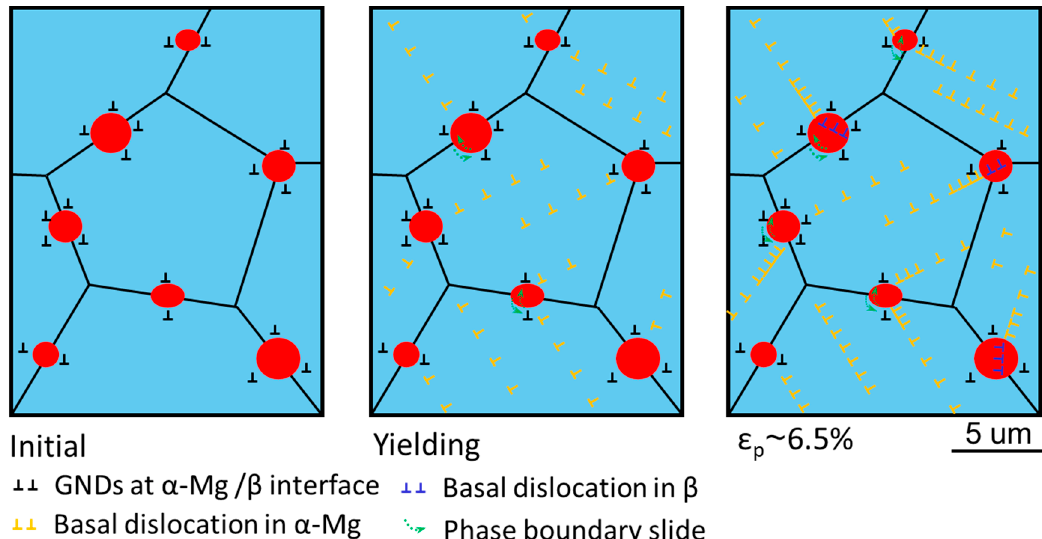
Figure 7. Schematic of the deformation mechanisms in the studied alloy.